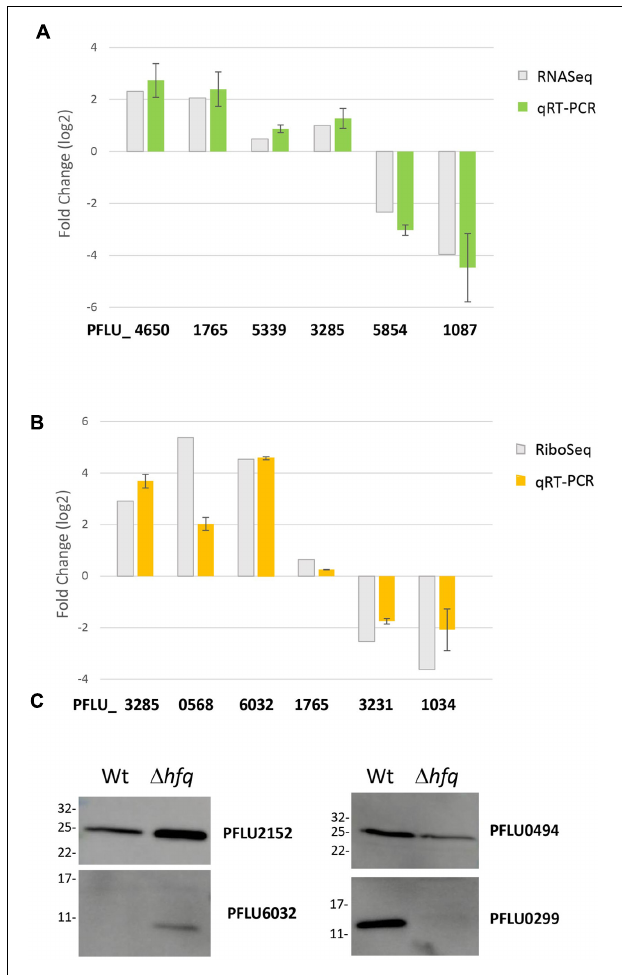
FIGURE 2 | Validation of candidate loci from the global analysis datasets. (A) Comparative mRNA abundance data for selected loci from the hfq transcriptome. (B) Comparative mRNA abundance data for selected loci from the hfq translatome. In each case, log 2 fold-change values are plotted for the hfq mutant versus WT SBW25. qRT-PCR values are presented alongside the corresponding fold-change observed in (A) the RNA-Seq experiment and (B) the Ribo-Seq experiment. The experiments were repeated at least twice. Data represents mean ± SD. (C) Western blots of selected flag-tagged proteins whose abundance changes in the Hfq proteome. The experiments were repeated at least twice. The representative blots are presented.